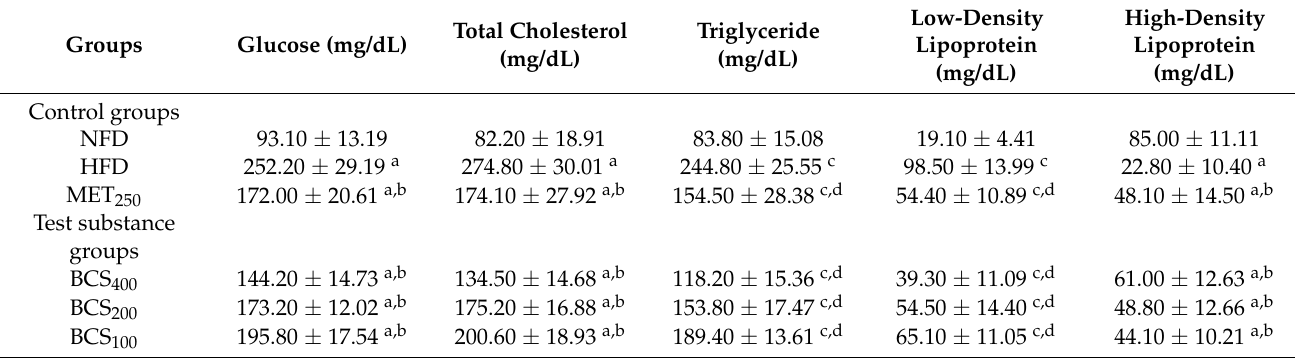
Table 4. Blood glucose and serum lipid content in HFD- and NFD-supplied groups.